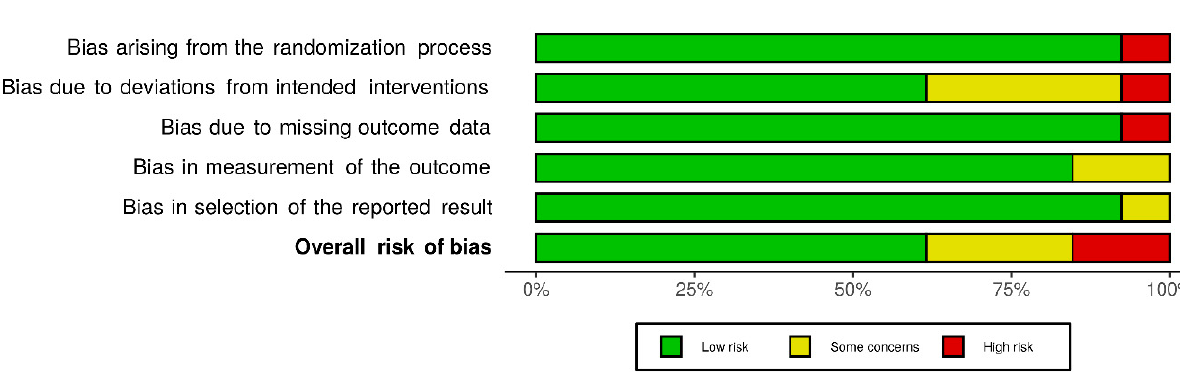
Figure 3. Risk of bias summary for included studies. Weighted bar-chart of the distribution of risk-of-bias judgments. These graphics were obtained using the robvis package within the R statistical computing environment.